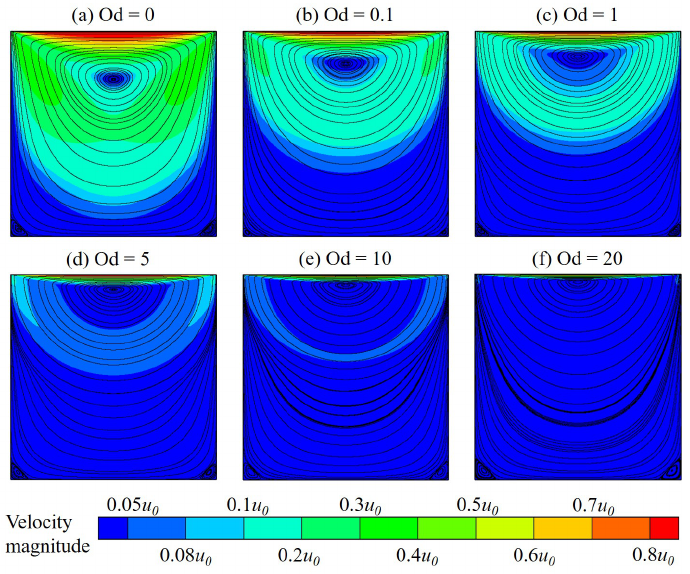
Figure 8. Velocity contour and flow streamlines of the polymer flow in a square lid-driven cavity at Od =